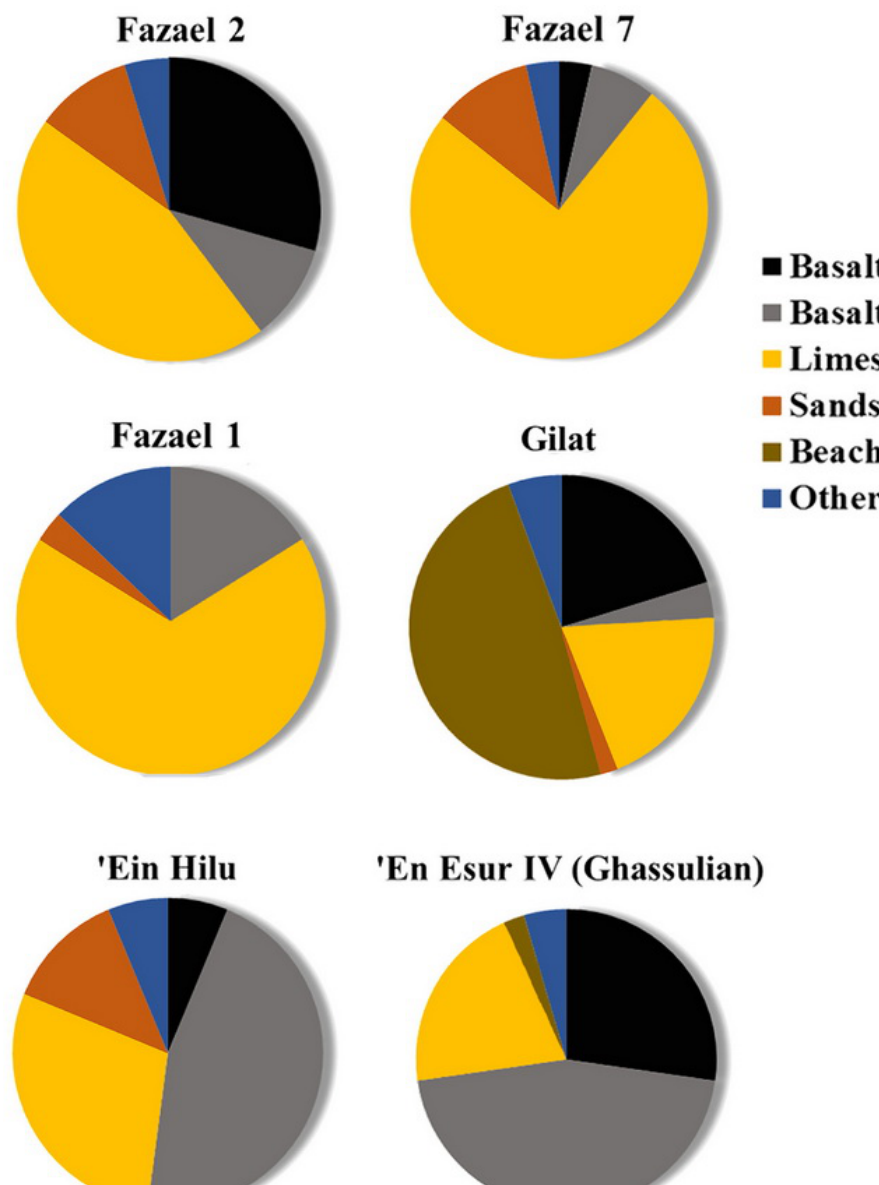
Figure 3. Raw materials for utilitarian ground stone tools in various Late Chalcolithic sites (data source, see Table